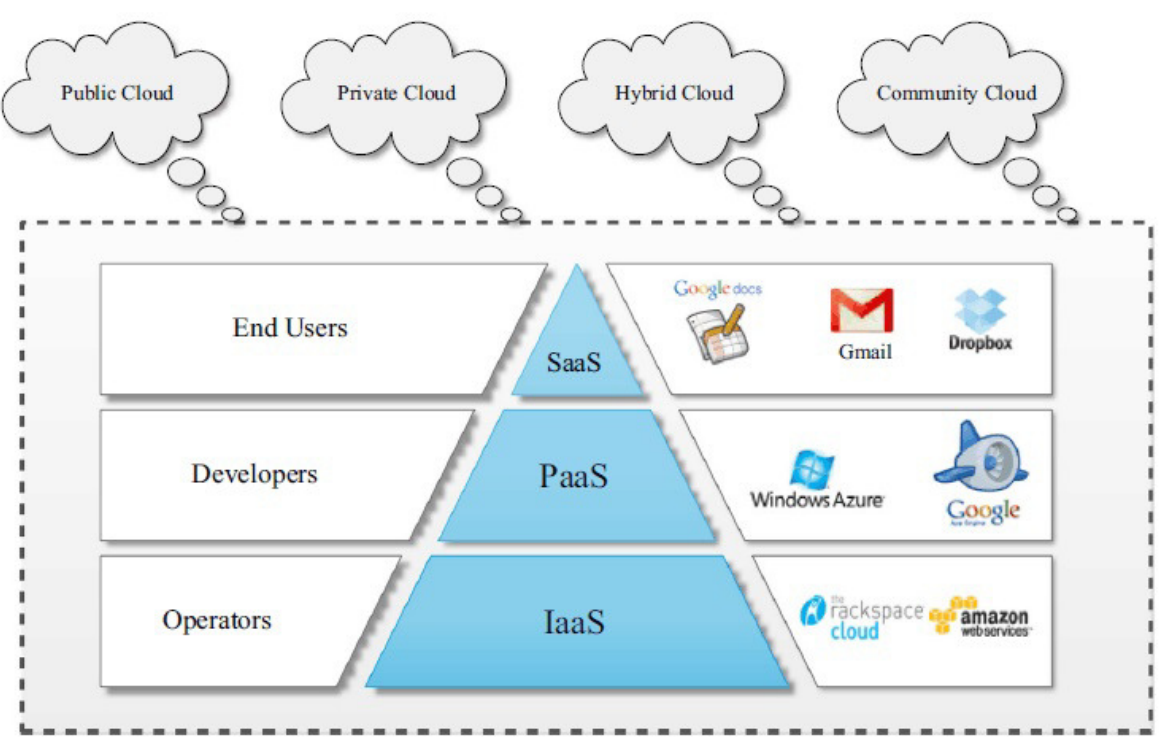
Fig. 2 Different service delivery models in cloud